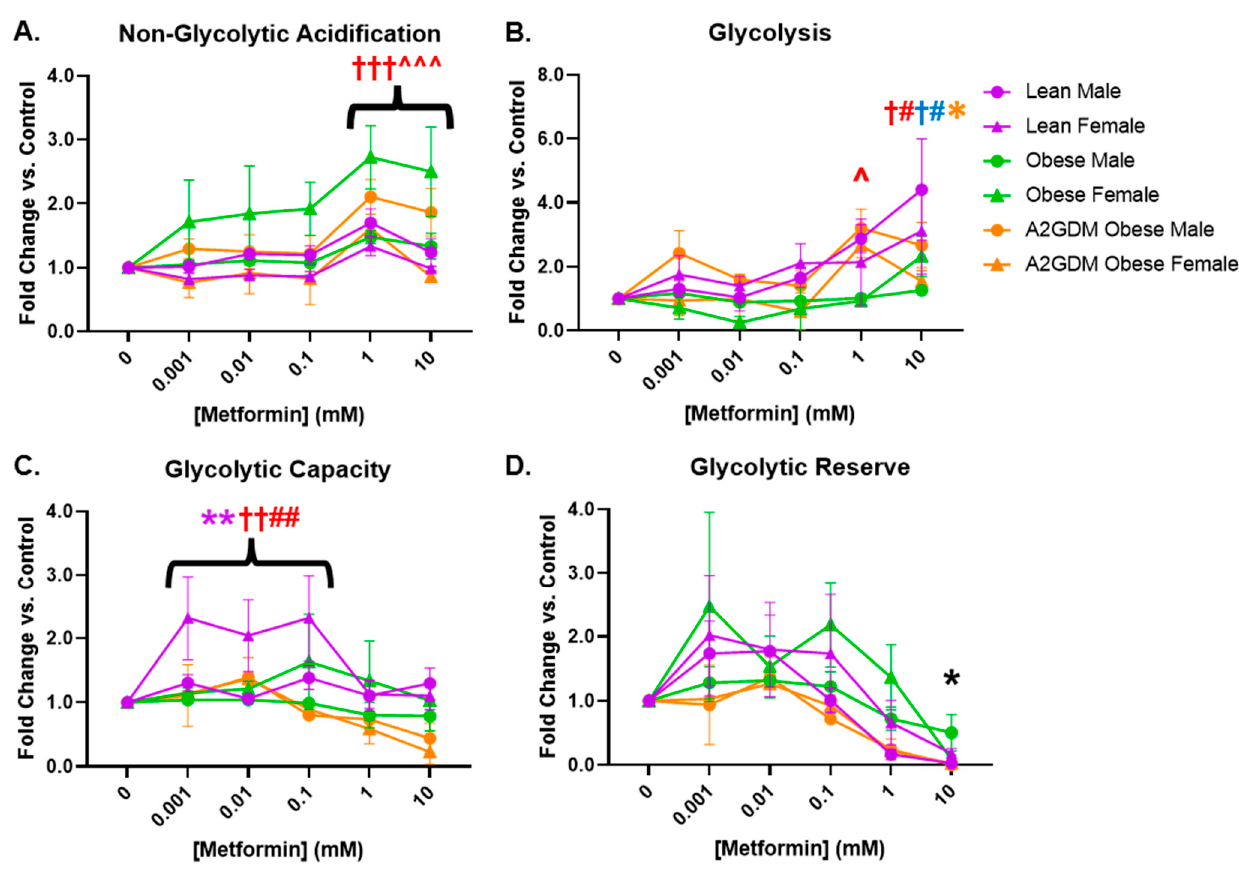
Figure 4. Glycolytic stress in syncytiotrophoblasts following metformin treatment as measured by ( A ) acidification not related to glycolysis, ( B ) glycolysis, ( C ) glycolytic capacity, and ( D ) glycolytic reserve. Values, normalized to no treatment controls, expressed as means ± SD. Statistical assessment was performed using 2-way ANOVA with Tukey post hoc. Level of significance: One symbol: p < 0.05. Two same symbol: p < 0.01. Three same symbol: p < 0.001. Difference at indicated metformin concentrations: Between sexes within group: Lean *, Obese *, A2GDM * . Lean vs. Obese Males † and Females †. Lean vs. A2GDM Males # and Females # . Obese vs. A2GDM Males ^ and Females ^ .